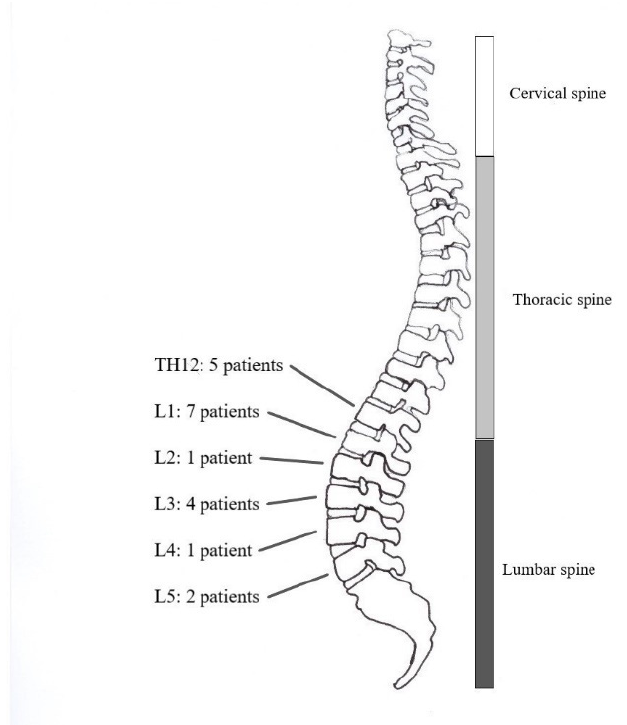
Figure 1. Number and distribution of fractured vertebral bodies per segment with kyphoplasty.